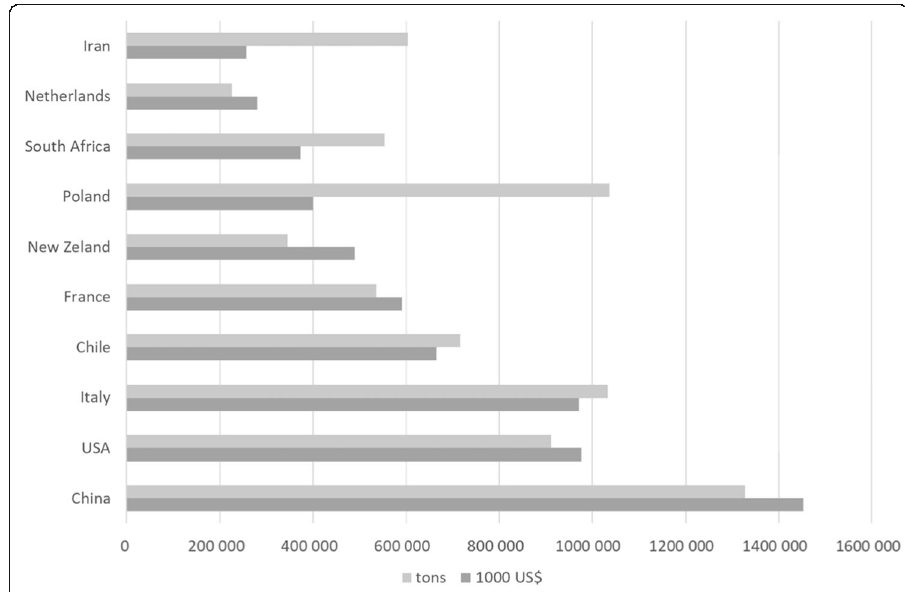
Fig. 1 Top 10 of the world apples exporters in 2017.